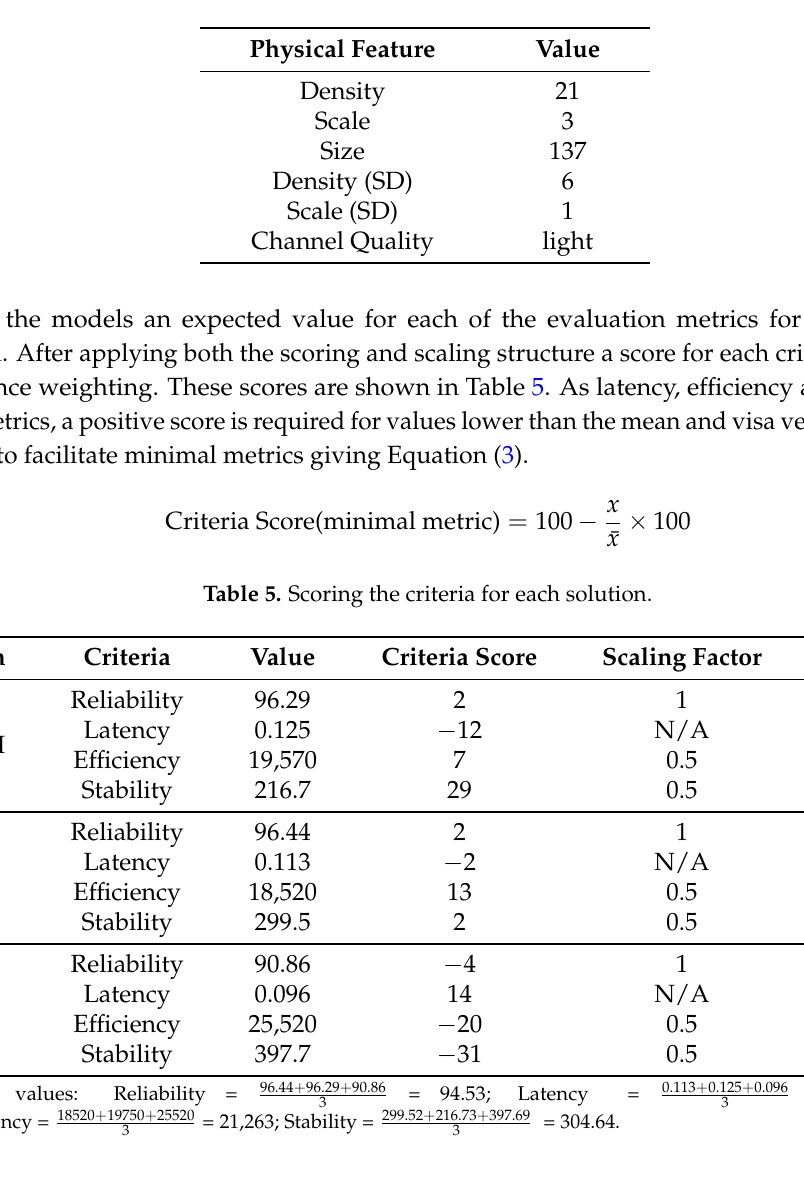
Table 4. Physical attributes of the network.